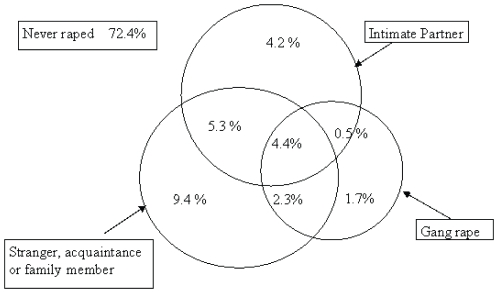
Venn diagram showing the overlaps between perpetration of rape of a girlfriend or wife, a non-partner and gang rape.